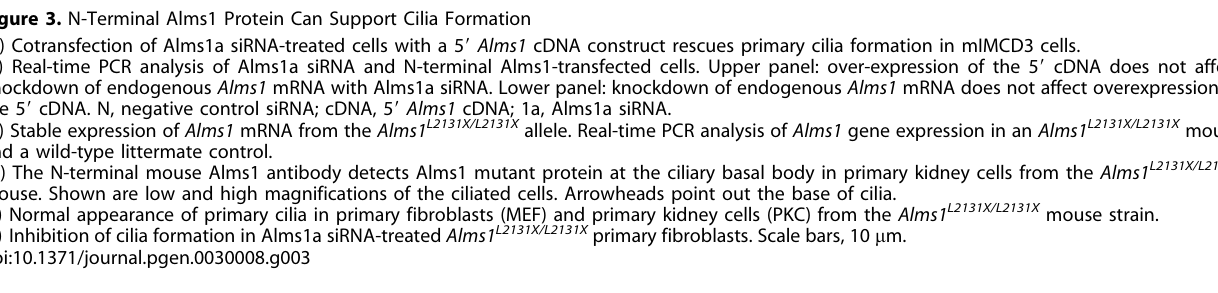
Figure 3. N-Terminal Alms1 Protein Can Support Cilia Formation (A) Cotransfection of Alms1a siRNA-treated cells with a 5 9 Alms1 cDNA construct rescues primary cilia formation in mIMCD3 cells. (B) Real-time PCR analysis of Alms1a siRNA and N-terminal Alms1-transfected cells. Upper panel: over-expression of the 5 9 cDNA does not affect knockdown of endogenous Alms1 mRNA with Alms1a siRNA. Lower panel: knockdown of endogenous Alms1 mRNA does not affect overexpression of the 5 9 cDNA. N, negative control siRNA; cDNA, 5 9 Alms1 cDNA; 1a, Alms1a siRNA. (C) Stable expression of Alms1 mRNA from the Alms1 L2131X/L2131X allele. Real-time PCR analysis of Alms1 gene expression in an Alms1 L2131X/L2131X mouse and a wild-type littermate control. (D) The N-terminal mouse Alms1 antibody detects Alms1 mutant protein at the ciliary basal body in primary kidney cells from the Alms1 L2131X/L2131X mouse. Shown are low and high magnifications of the ciliated cells. Arrowheads point out the base of cilia. (E) Normal appearance of primary cilia in primary fibroblasts (MEF) and primary kidney cells (PKC) from the Alms1 L2131X/L2131X mouse strain. (F) Inhibition of cilia formation in Alms1a siRNA-treated Alms1 L2131X/L2131X primary fibroblasts. Scale bars, 10 l m.